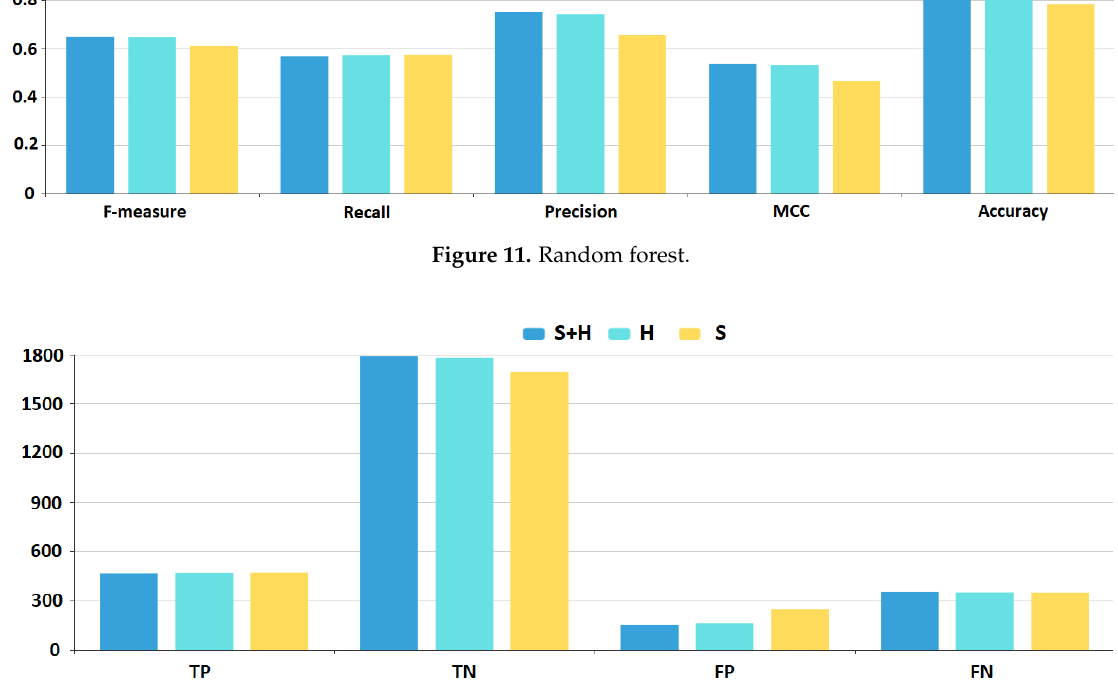
Figure 12. Random forest.